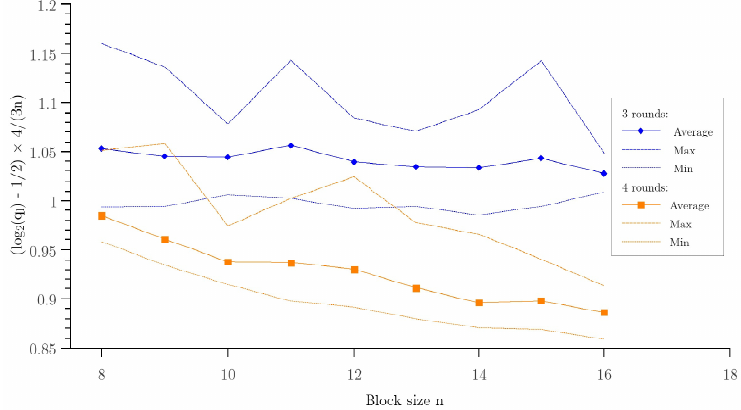
Figure 9: Experimental resilience of MOE n against linear attacks for small block sizes n .